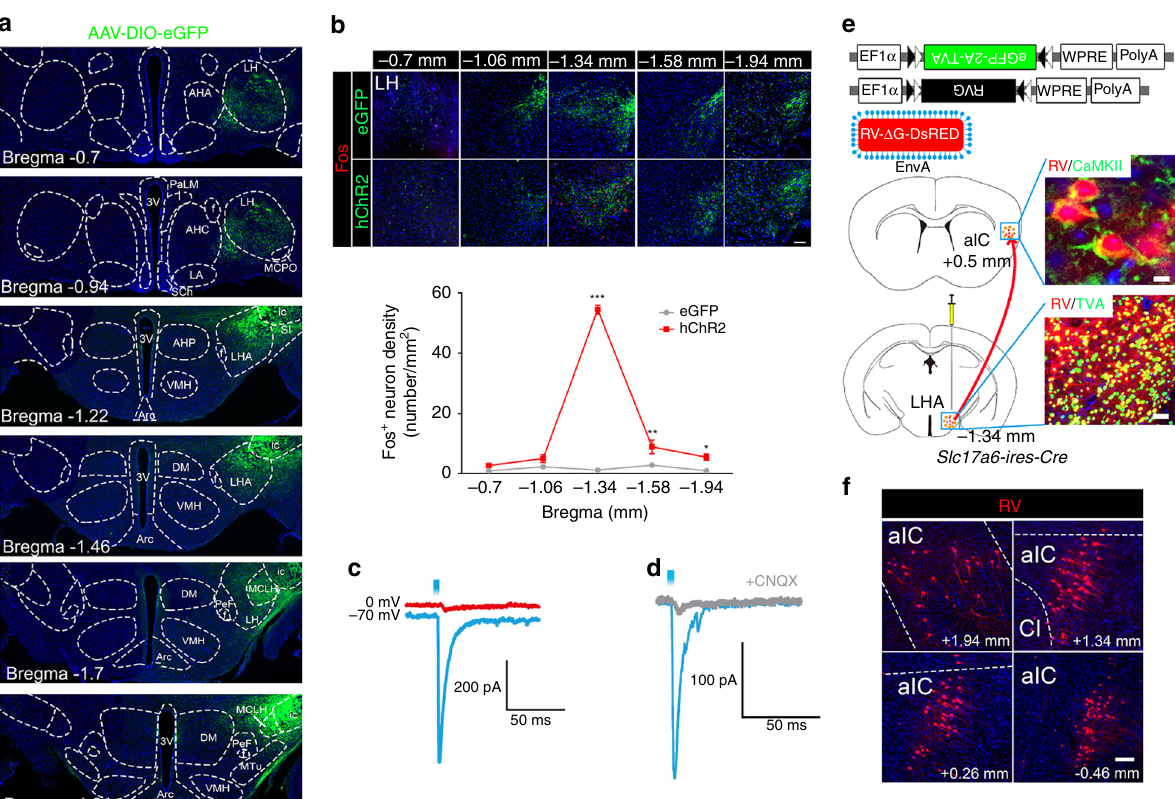
Fig. 6 Right aIC CamKII neurons project to the LH directly. a Representative histology of images from the LH showing CamKII + fi ber terminal in green after injecting hSyn-DIO-eGFP into the right aIC of Camk2a-Cre mice. Distribution of the fi ber terminals in the area of hypothalamus is shown from bregma − 0.70 mm to bregma − 1.94 mm. Scale bar, 250 μ m. AHA anterior hypothalamic area, anterior part; AHC anterior hypothalamic area, central part; Arc arcuate hypothalamic nucleus; f fornix; LA lateroanterior hypothalamic nucleus; 3V 3rd ventricle; ic internal capsule; SI substantia innominate; AHP anterior hypothalamic area, posterior part; MTu medial tuberal nucleus; VMH ventromedial hypothalamic nucleus; MCLH magnocellular nucleus of the lateral hypothalamic; DM dorsomedial hypothalamic nucleus; PeF perifornical nucleus; PaLM paraventricular hypothalamic nucleus, lateral magnocellular part; SCh suprachiasmatic nucleus; MCPO magnocellular preoptic nucleus. b eGFP or hChR2-eGFP injected in the right aIC and the terminals in LH were activated by light and immunostained with Fos (red) 30 min after light stimulation ( n = 5 mice per group, Two-way ANOVA with Bonferroni post hoc analysis). Scale bar, 200 μ m. c Light can evoke EPSCs (held at − 70 mV), but not IPSCs (held at 0 mV). n = 6 cells. d Single light evoked EPSC, which can be blocked by CNQX. n = 5 cells. e Diagram illustrating the injected virus (AAV-FLEX-eGFP-2A-TVA, AAV-FLEX-RVG, and Δ RVG-DsRed) (upper) and injection sites (lower) for rabies-based projection-speci fi c monosynaptic tracing of inputs to LH vGluT2 neurons in Slc17a6-ires-Cre mice. Rabies are colocalized with CamKII in the right aIC (upper). Neurons co-infected (starter cell) with helper AAV and rabies are shown in yellow. f Distribution of monosynaptic input (Rabies-DsRed neurons) from the right aIC to the LH VGluT2 . Scale bar, 100 μ m (Right upper). Scale bar, 25 μ m (Right lower). Source data are provided as a Source Data fi